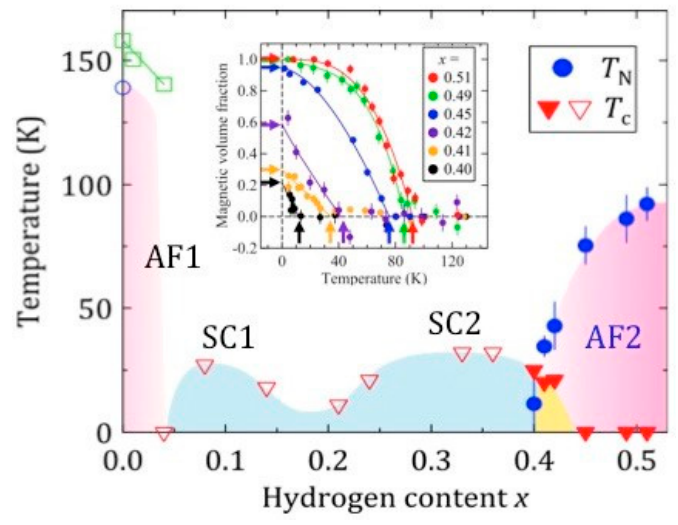
Figure 17. New magnetic phase (AF2), for which the Néel temperature ( T N ) was mapped out by performing µSR measurements. Inset: Magnetic volume fraction vs. temperature determined via µSR [33]. T c : superconducting transition temperature.